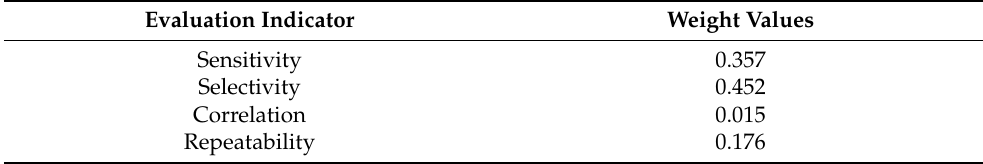
Table 4. The weight values of the evaluation indicators calculated based on